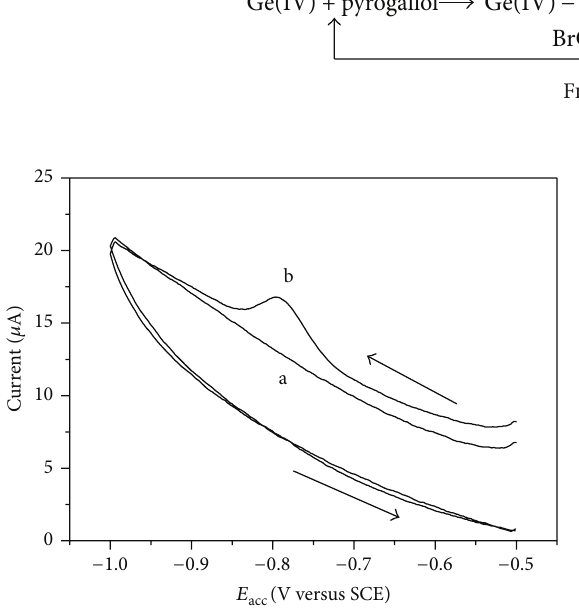
Figure 3: Cyclic voltammograms recorded at a BiFE plated in Figure 5: The effect of the pyrogallol concentration on the stripping 1molL −1 acetate buffer (pH 4.5) containing 0.08 mol/L trisodium peak current of Ge(IV)-pyrogallol complex in 0.1molL −1 HAc- citrate: (a) 0.1mol L −1 HAc-NaAc (pH 4.8) + pyrogallol ( 1.3 × NaAc + 3 × 10 −4 molL −1 KBrO 3 ; Ge(IV) concentration: 10 𝜇 gL −1 . 𝜇 gL −1 ); 10 −3 molL −1 ) + 2 × 10 −4 mol L −1 KBrO Other conditions as in Figure 1. 3 ; (b) a + Ge(IV) (20 deposition potential: − 0.34V; deposition time: 150s; potential scan rate: 50mVs −1 .